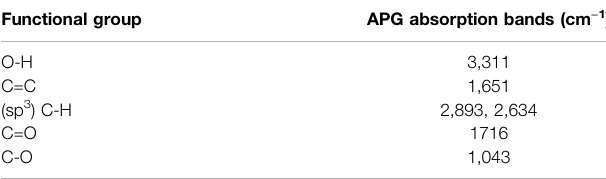
TABLE 2 | IR absorption band of APG isolated from Hibiscus rosa-sinensis